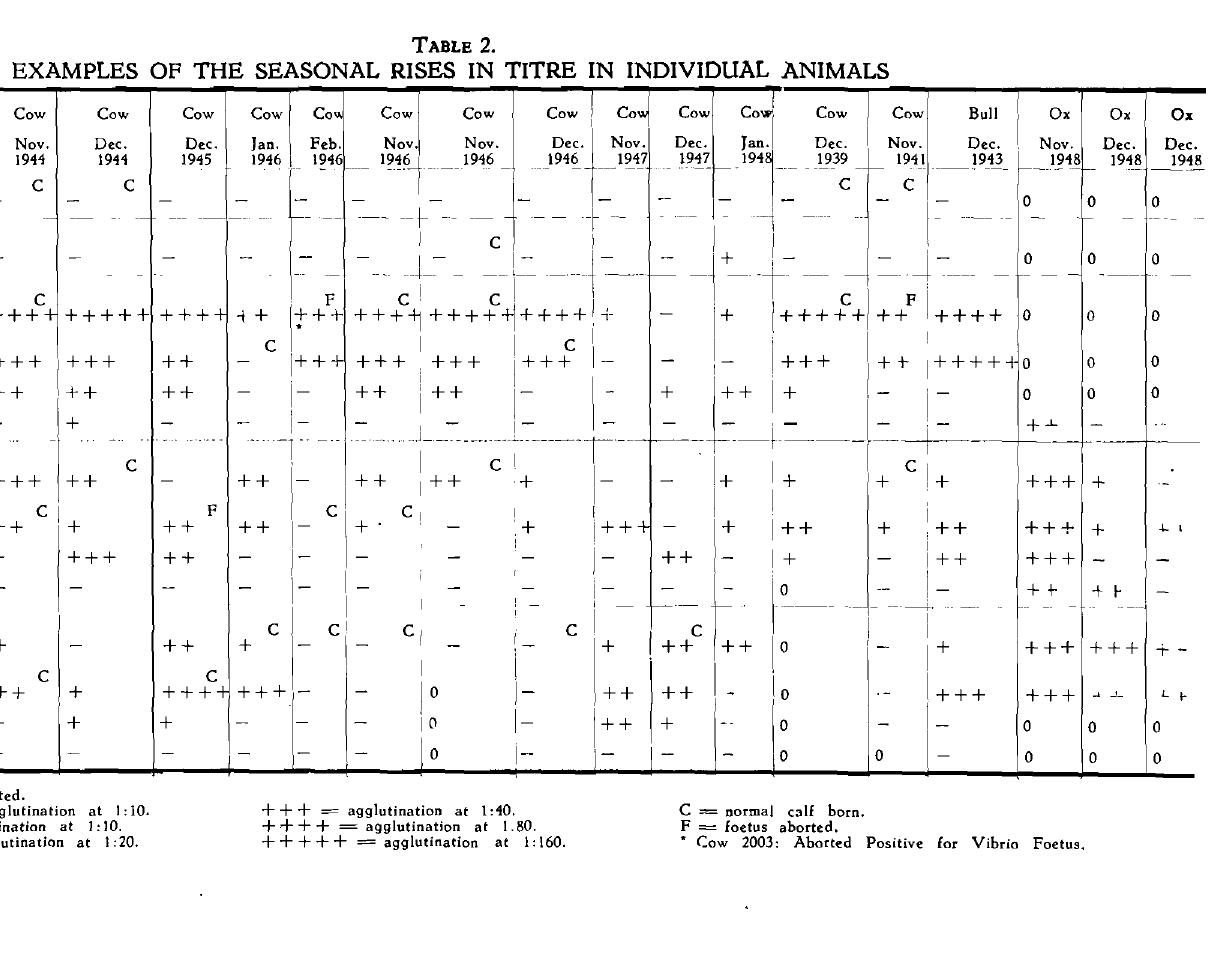
TABLE 2. EXAMPLES OF THE SEASONAL RISES IN TITRE IN INDIVIDUAL ANIMALS